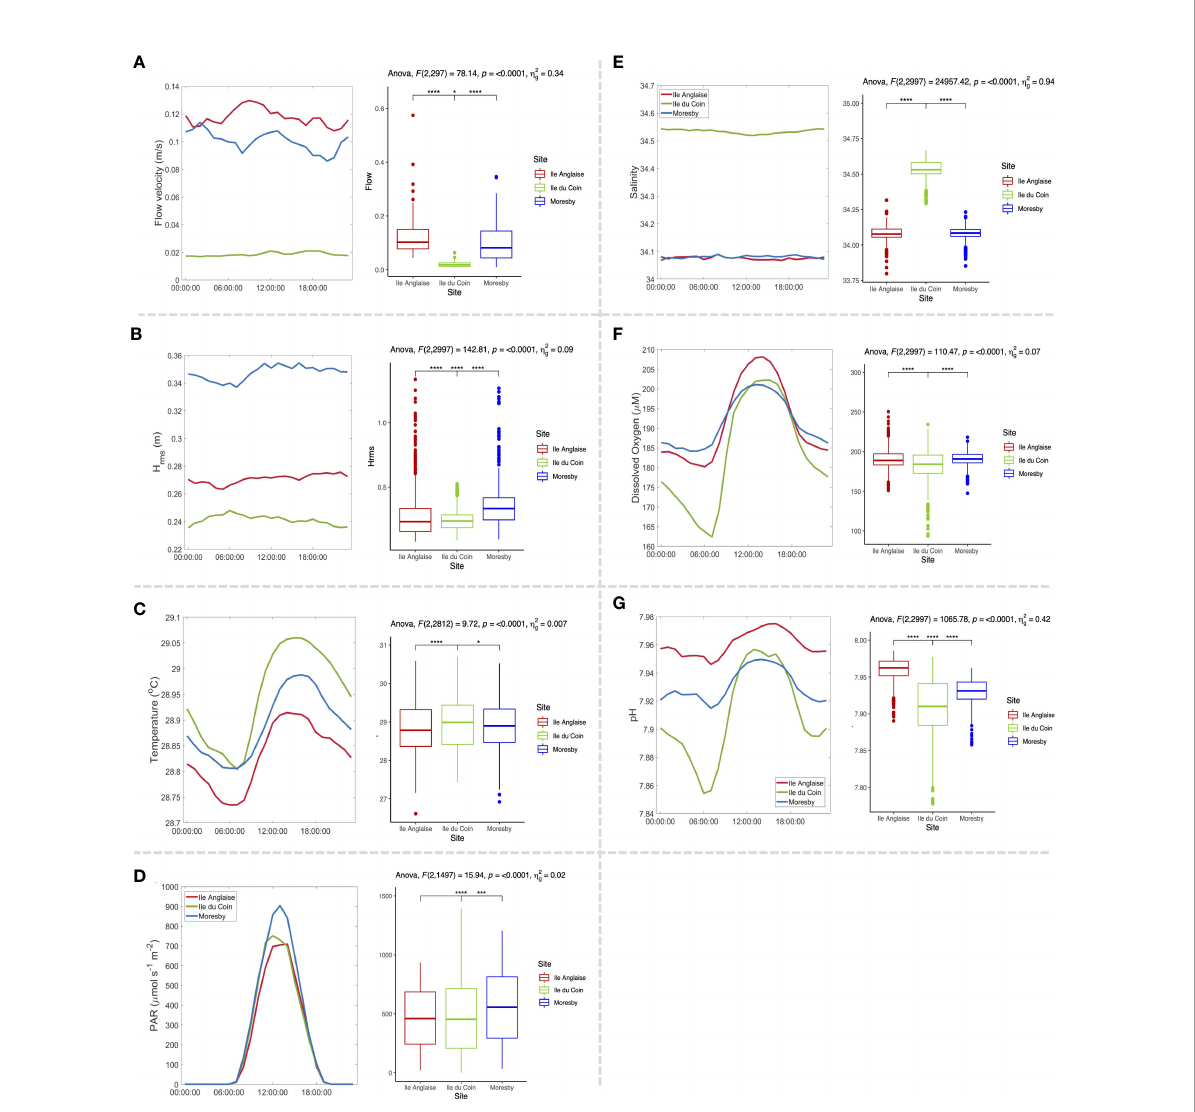
FIGURE 2 Average diel cycle plots for (A) fl ow velocity, (B) root-mean-square wave height, (C) in situ temperature, (D) photosynthetically active radiation (PAR), (E) salinity, (F) dissolved oxygen (DO), (G) pH, and, and boxplots displaying values across subset datasets for each parameter, along with corresponding one-way ANOVA test results [including F -statistic with degrees of freedom, p -value, and effect size (generalised eta squared ( n g2